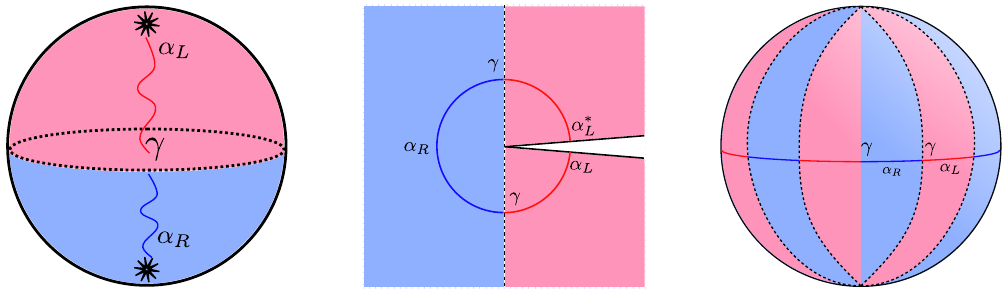
Figure 9 . (Left) The state prepared on the two-sphere with anyon punctures. The middle point of the Wilson lines tunnel the interface through the e(cid:11)ective theory in a (cid:12)xed The reduced density matrix (obtained by suppressing the azymuthal and conformally mapping to the Euclidean plane). (Right) The replicated manifold representing Tr (cid:26) n dimension and so the intersection of the interfaces is inaccurately represented as two isolated points when they are actually a line (cid:12)xed under the Z n replica